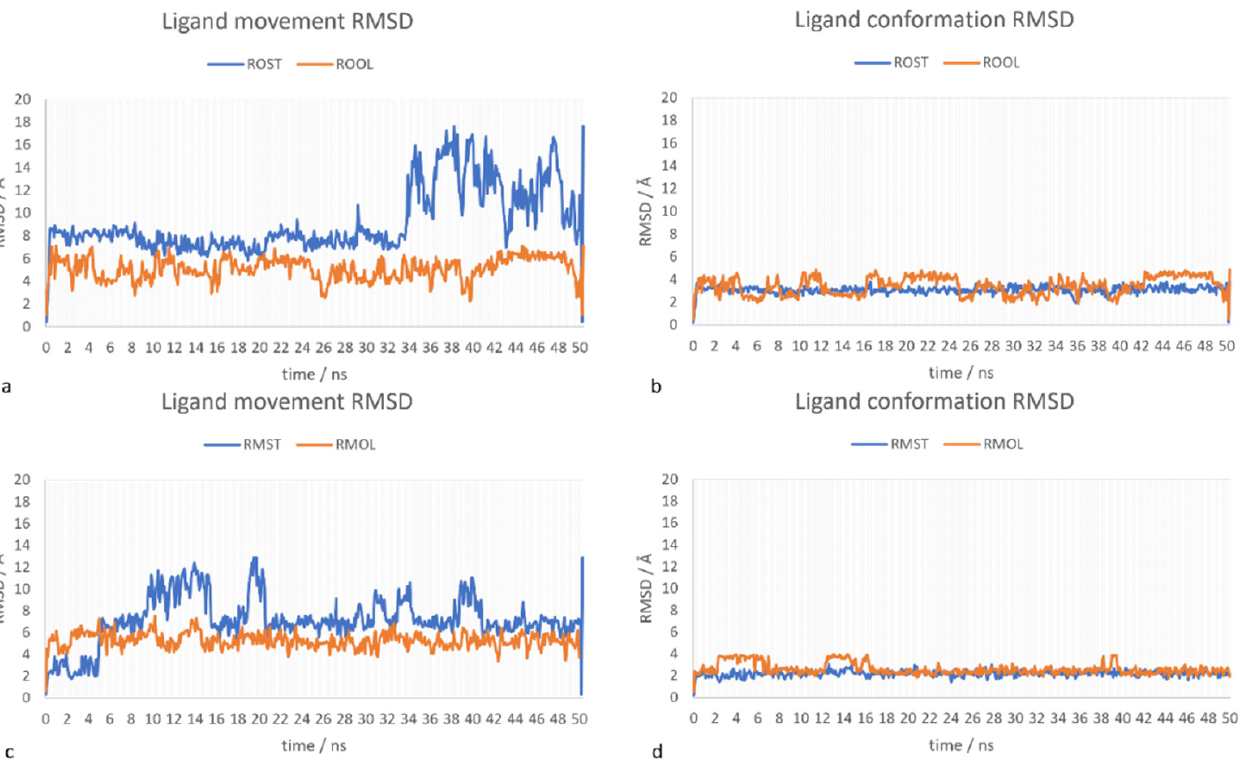
Figure 6. Ligand RMSD after superposing on the ligand as a function of simulation time generated from 50 ns MD simulation with cyclohexane as solvent. Plot ( a ). Ligand movement RMSD of ROST and ROOL; ( b ). ligand conformation RMSD of ROST and ROOL; ( c ). ligand movement RMSD of RMST and RMOL; ( d ). ligand conformation RMSD of RMST and RMOL.